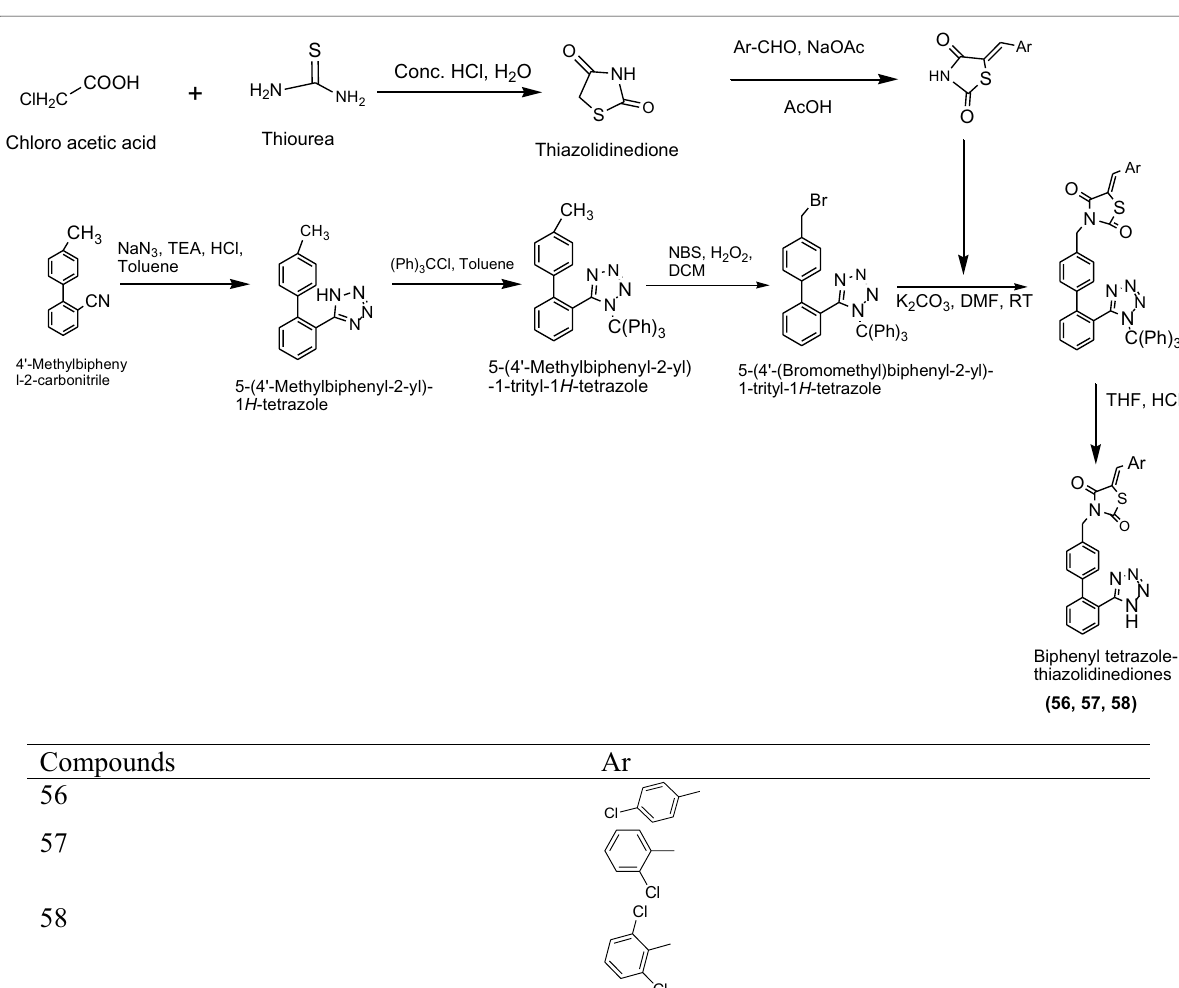
ClCl thiazolidin-3-yl)isonicotinamide) result in wide spectrum antimicrobial activity against all the test bacteria and fungi using ciprofloxacin and clotrimazole as a standard drug respectively. The results of synthesized compounds pre- sented in Table 20 (Sharma et al. [25]).